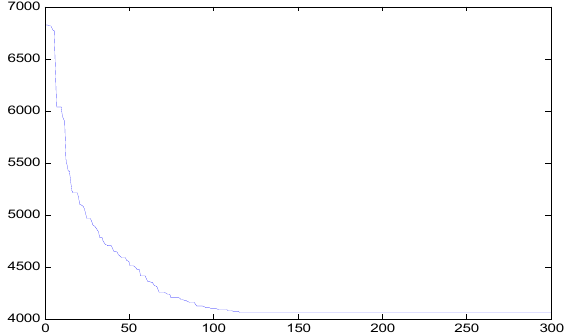
Figure 6. The plot for Total cost of integrated manufacturing function in MATLAB.